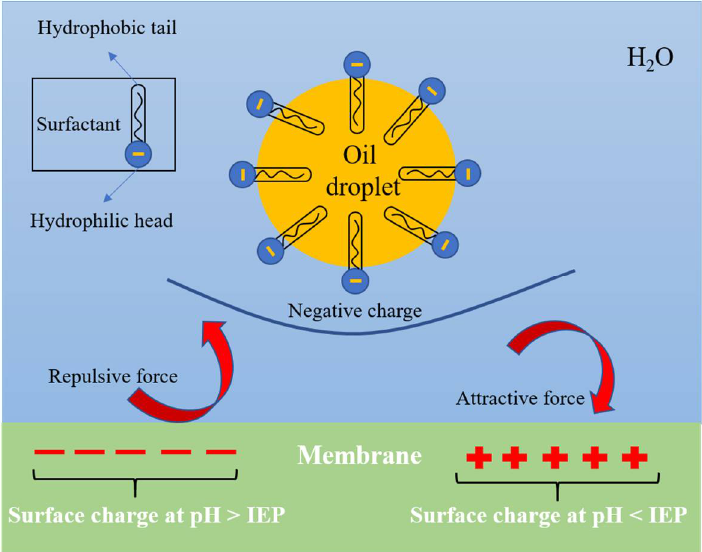
Figure 1. Interaction between the oil droplets stabilized by anionic surfactant and the membrane at various pH values. Table 2. The IEP of common ceramic materials in the water at 25 °C [135–138].